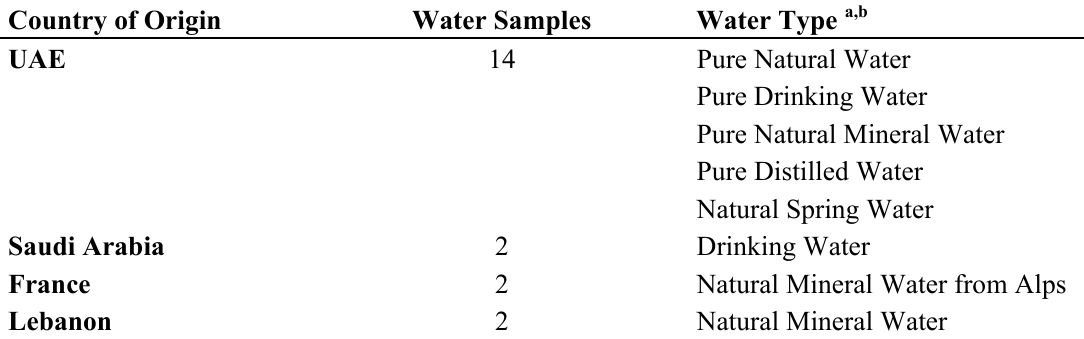
Table 1. Bottled water samples purchased from the UAE